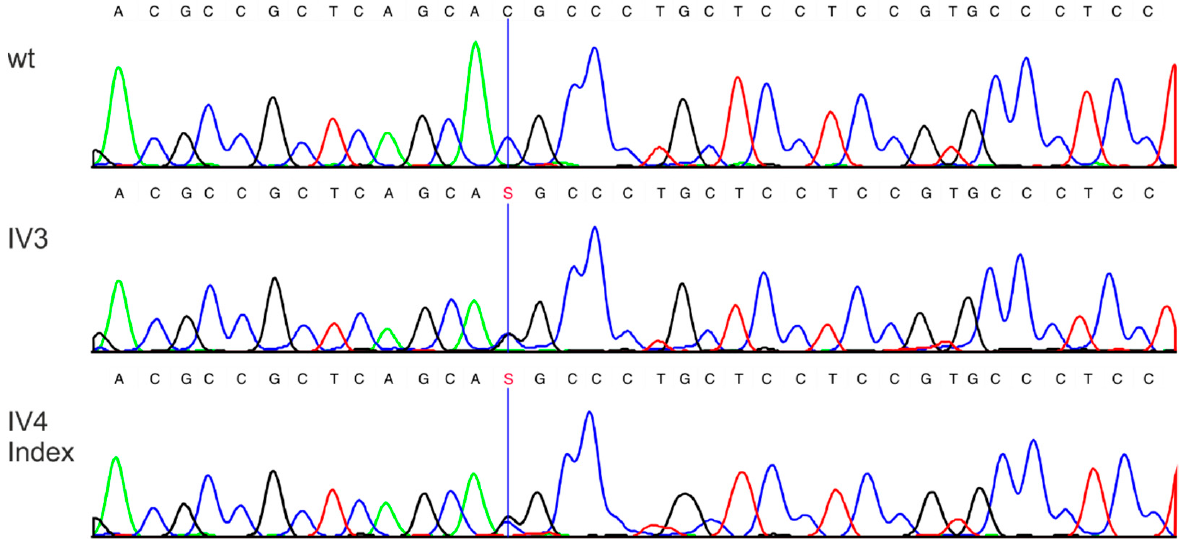
Figure 5. Confirmation of variant NM_201589.3 ( MAFA ): c.170C>G, p.Thr57Arg, in the two affected siblings by Sanger sequencing. wt: healthy control; IV3 corresponds to case 2 (Figure 1); IV4 Index to case 1.